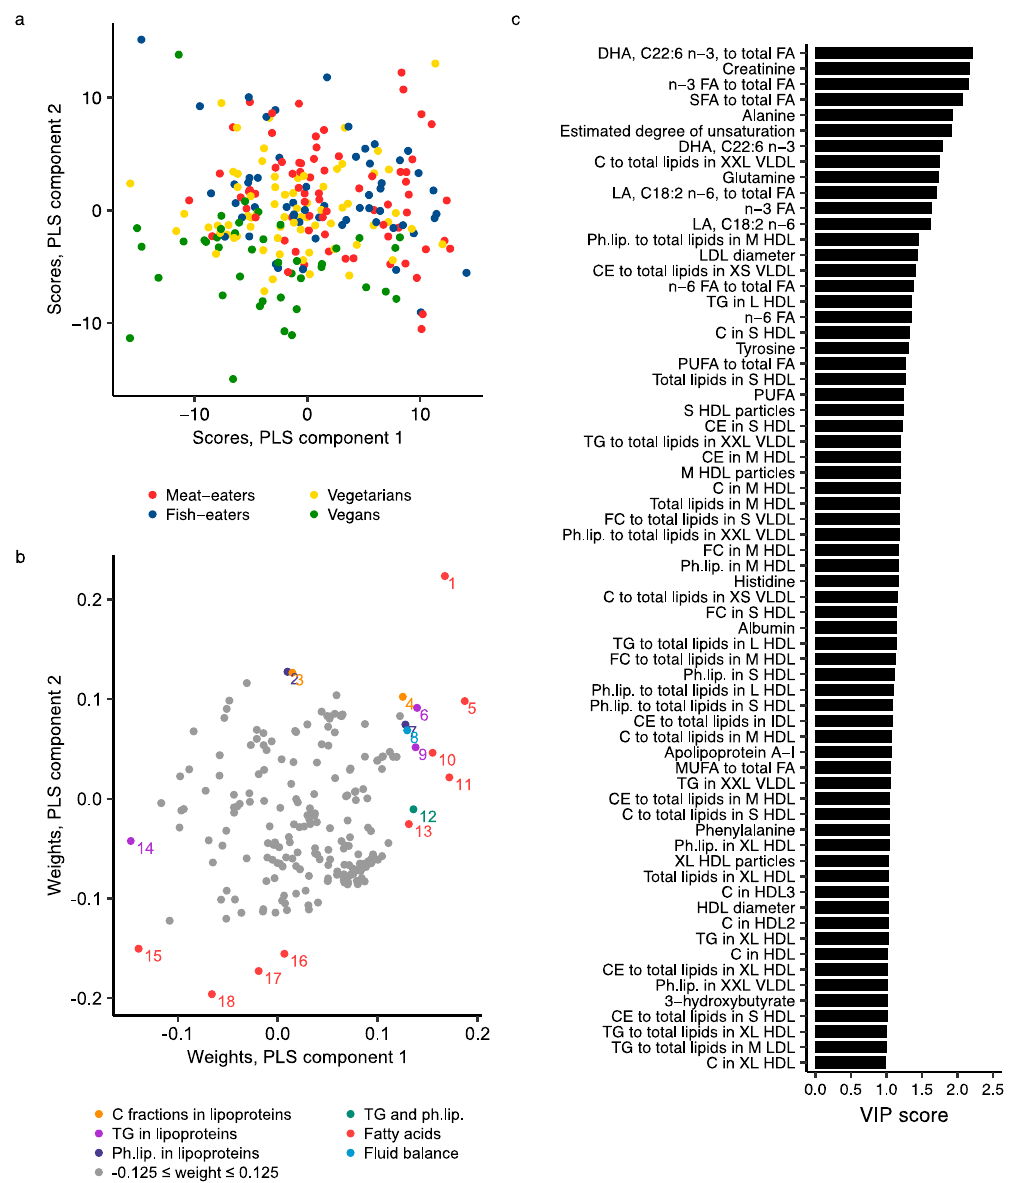
Figure 4. PLS model of 207 NMR metabolite measures by four diet groups. ( a ) Score plot of PLS components 1 and 2 coloured by diet group; ( b ) Weights plot of PLS components 1 and 2. Metabolites with weights more extreme than ±0.125 on either PLS component are coloured and labelled: 1, Saturated to total fatty acids; 2, Phospholipids to total lipids in S HDL; 3, Free cholesterol to total lipids in S HDL; 4, Cholesterol esters to total lipids in XS VLDL; 5, DHA, C22:6 n-3, to total fatty acids; 6, Triglycerides in L HDL; 7, Phospholipids to total lipids in M HDL; 8, Creatinine; 9, Triglycerides in XL HDL; 10, n-3 to total fatty acids; 11, DHA, C22:6 n-3; 12, Sphingomyelins; 13, n-3 fatty acids; 14, Triglycerides to total lipids in XL VLDL; 15, Linoleic acid, C18:2 n-6, to total fatty acids; 16, Polyunsaturated fatty acids; 17, n-6 fatty acids; 18, Linoleic acid, C18:2 n-6; ( c ) Variable influence on projection (VIP) scores, representing the contribution of metabolites to the PLS model; metabolites with VIP > 1 are included in the figure. Further details are given in Table S5. Abbreviations: C, total cholesterol; CE, cholesterol esters; C fractions, cholesterol fractions, i.e., total cholesterol, cholesterol esters and free cholesterols; DHA, docosahexaenoic acid; FA, fatty acids; FC, free cholesterol; HDL, high-density lipoprotein; IDL, intermediate-density lipoprotein; L, large; LA, linoleic acid; LDL, low-density lipoprotein; M, medium; MUFA, monounsaturated fatty acids; Ph.lip., phospholipids; PLS, partial least squares; PUFA, poly unsaturated fatty acids; S, small; SFA, saturated fatty acids; TG, triglycerides; VIP, variable influence on projection; VLDL, very-low-density lipoprotein; XL, extra-large; XS, extra-small; XXL, chylomicrons and extremely large. When comparing only meat-eaters and vegans (the most extreme groups), the best model included six components and showed higher goodness of fit (R 2 Y = 0.803) and